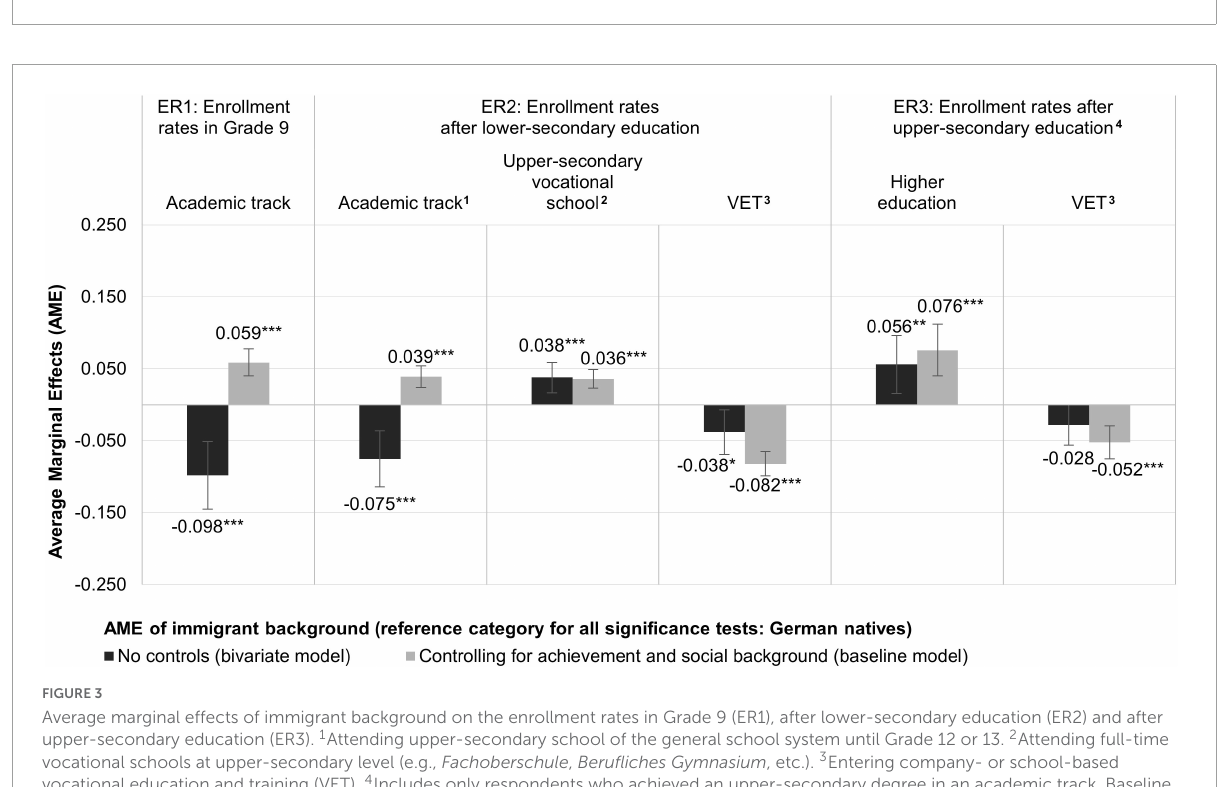
FIGURE3 Average marginal effects of immigrant background on the enrollment rates in Grade 9 (ER1), after lower-secondary education (ER2) and after upper-secondary education (ER3). 1 Attending upper-secondary school of the general school system until Grade 12 or 13. 2 Attending full-time vocational schools at upper-secondary level (e.g., Fachoberschule , Berufliches Gymnasium , etc.). 3 Entering company- or school-based vocational education and training (VET). 4 Includes only respondents who achieved an upper-secondary degree in an academic track. Baseline model adjusted for gender, school track in Grade 9 (not used for ER1), federal state of residency, school grades, competence score in Maths, Reading, and ICT-Literacy, highest parental socio-economic status, and educational level. KHB corrected estimates. Reference category for all significance tests are German natives. Robust standard errors on school level. Level of significance: *** p < 0.001; ** p < 0.01; * p < 0.05. Imputed data ( m =